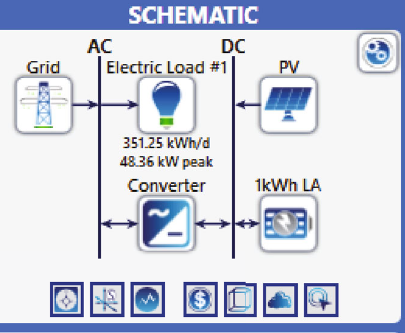
Figure 5: Schematic diagram of the energy system.